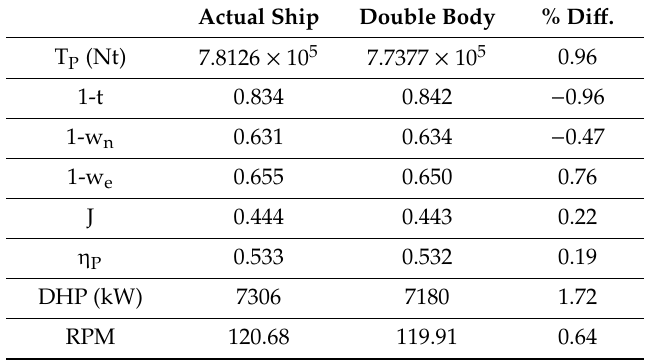
Table 10. Di ff erences in the propulsive characteristics between the real ship and the double